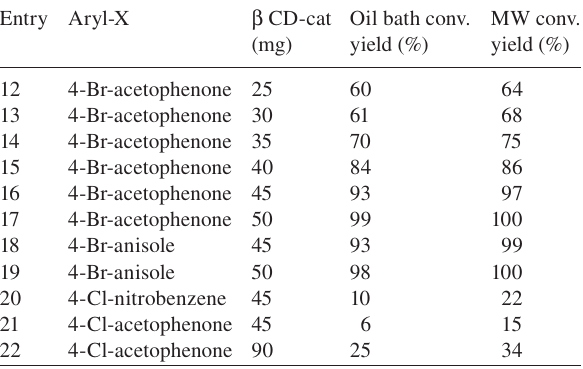
Table 3 Suzuki reaction: oil bath vs. MW irradiation under pressure with different amount of β -CD/Pd (II) catalyst.